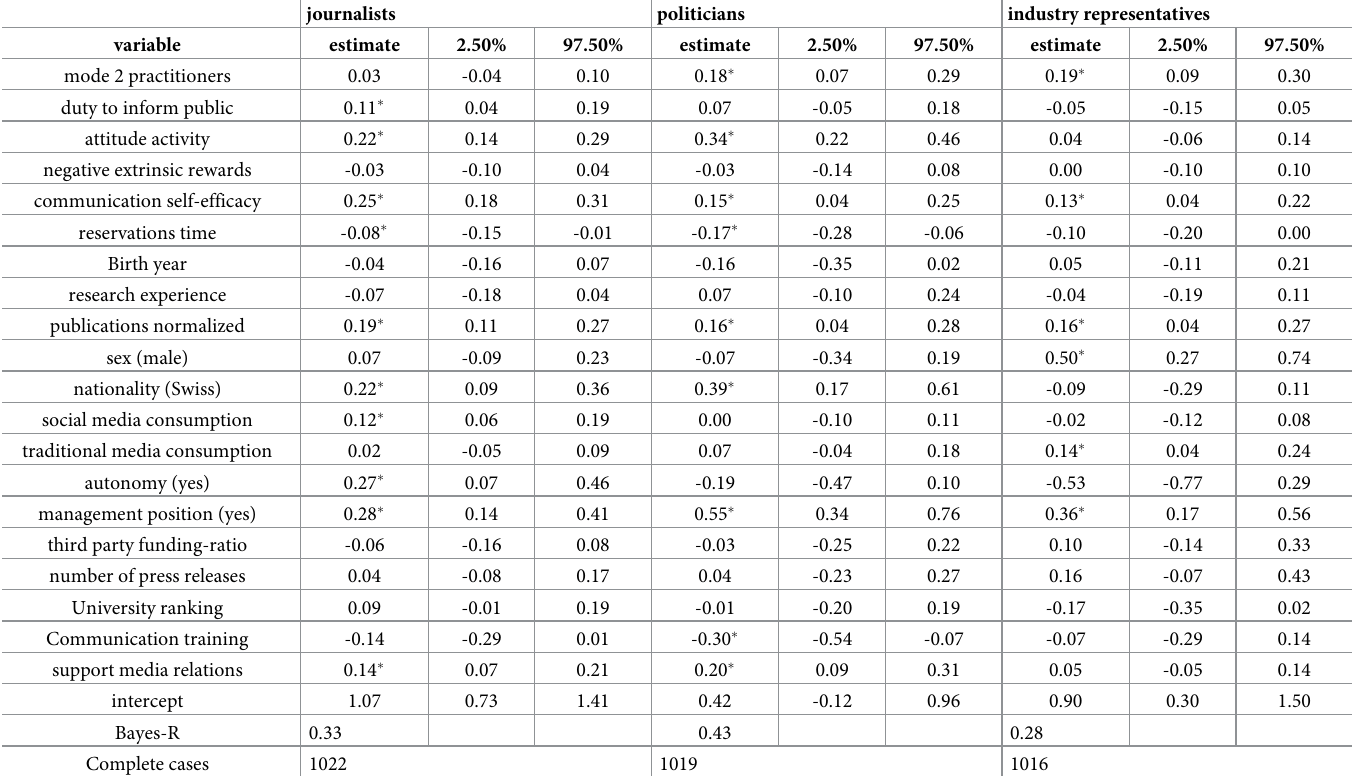
Table 2. Estimates of all three models (Bayesian negative-binomial regressions with varying intercepts for universities and disciplines). journalists politicians industry